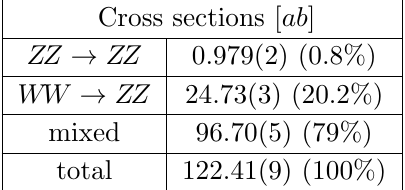
Table 10 . Cross sections ( ab ) for the VBS ZZ production in the absence of lepton cuts. The mixed contribution refers to partonic subprocesses which include both ZZ scattering subdiagrams. In parentheses we show the relative